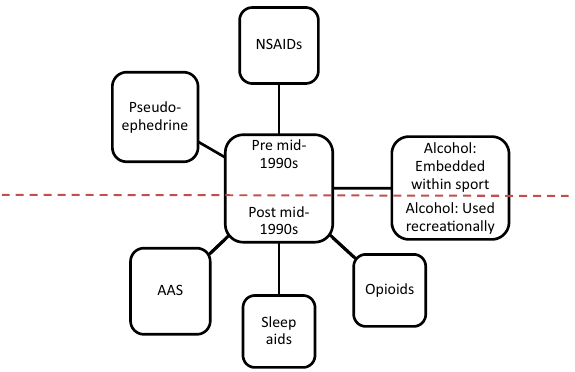
Figure 1. Patterns of substance use by era. During the era pre mid-1990s, substances such as alcohol, non- steroidal anti-inflammatories (NSAIDs), and pseudoephedrine were prevalent in dressing rooms and during travel. During the era post mid-1990s, substances like opioids and sleep aids were frequently used as were anabolic–androgenic steroids